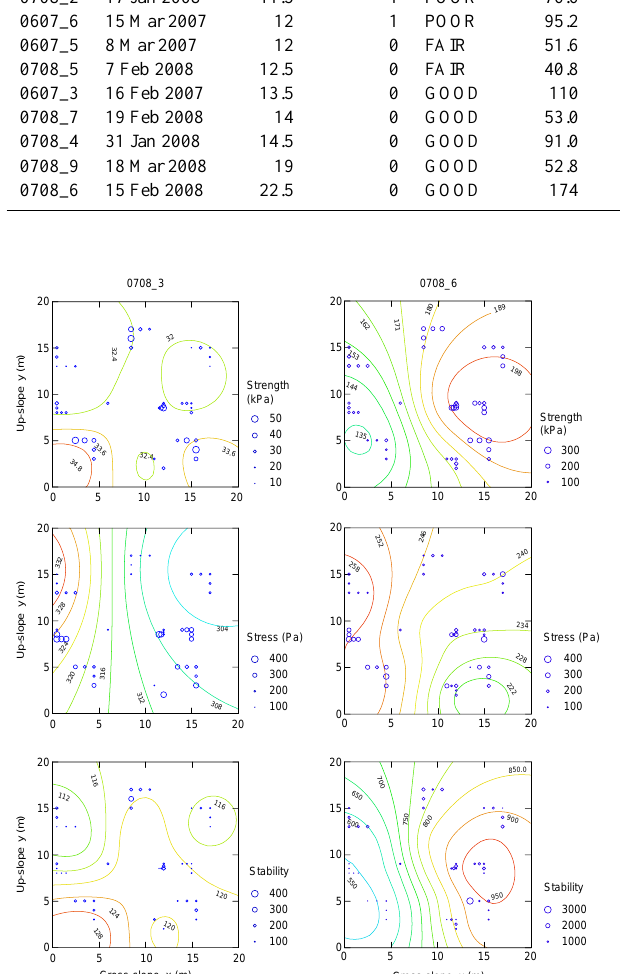
Figure 7. Contour plots of strength, stress (load) and stability index for two exemplary grids in winter 2007–2008. Grid 0708_3 (left) represents a rather unstable slope, whereas grid 0708_6 (right) rep- resents a rather stable